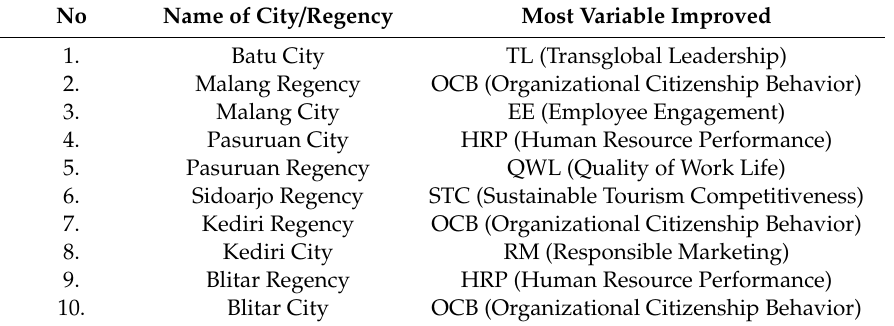
Table 4. Research